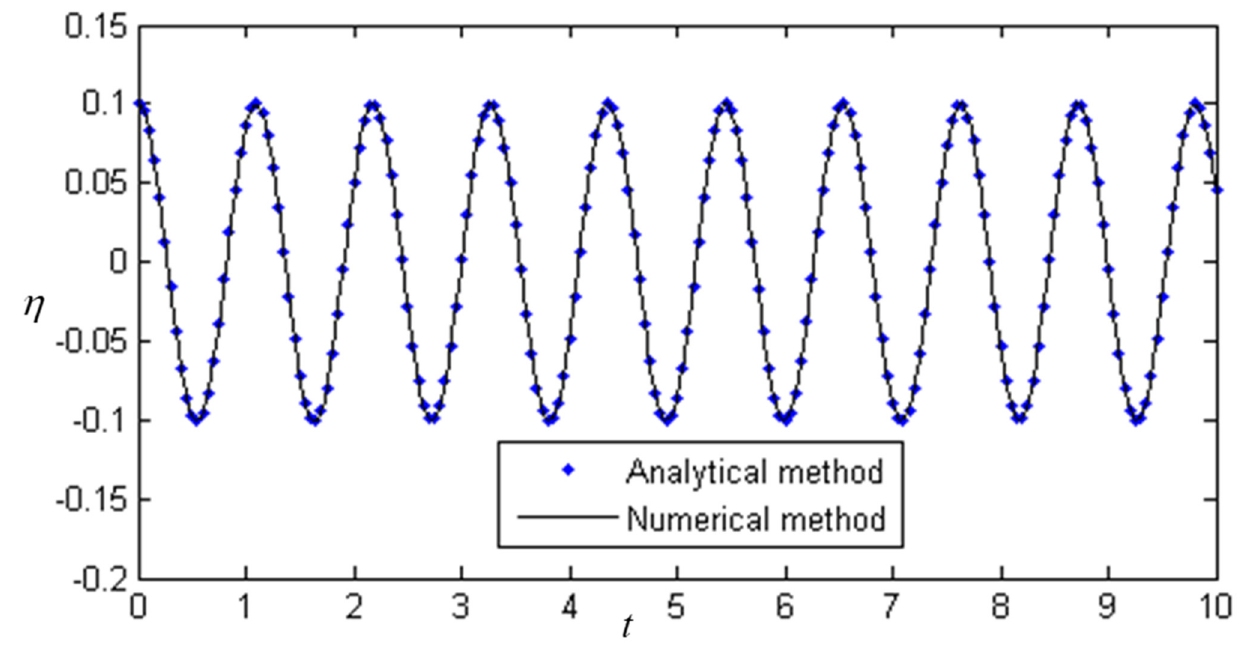
Figure 9. Comparison between the supercritical analytical solution (57) and the numerical solution for weakly nonlinear cases.